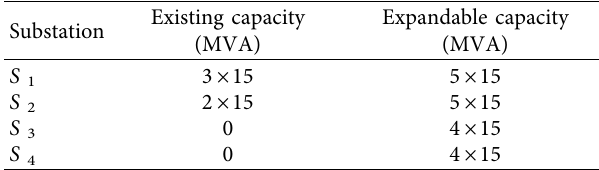
Table 8: Pollution emission rates of the DG technologies.